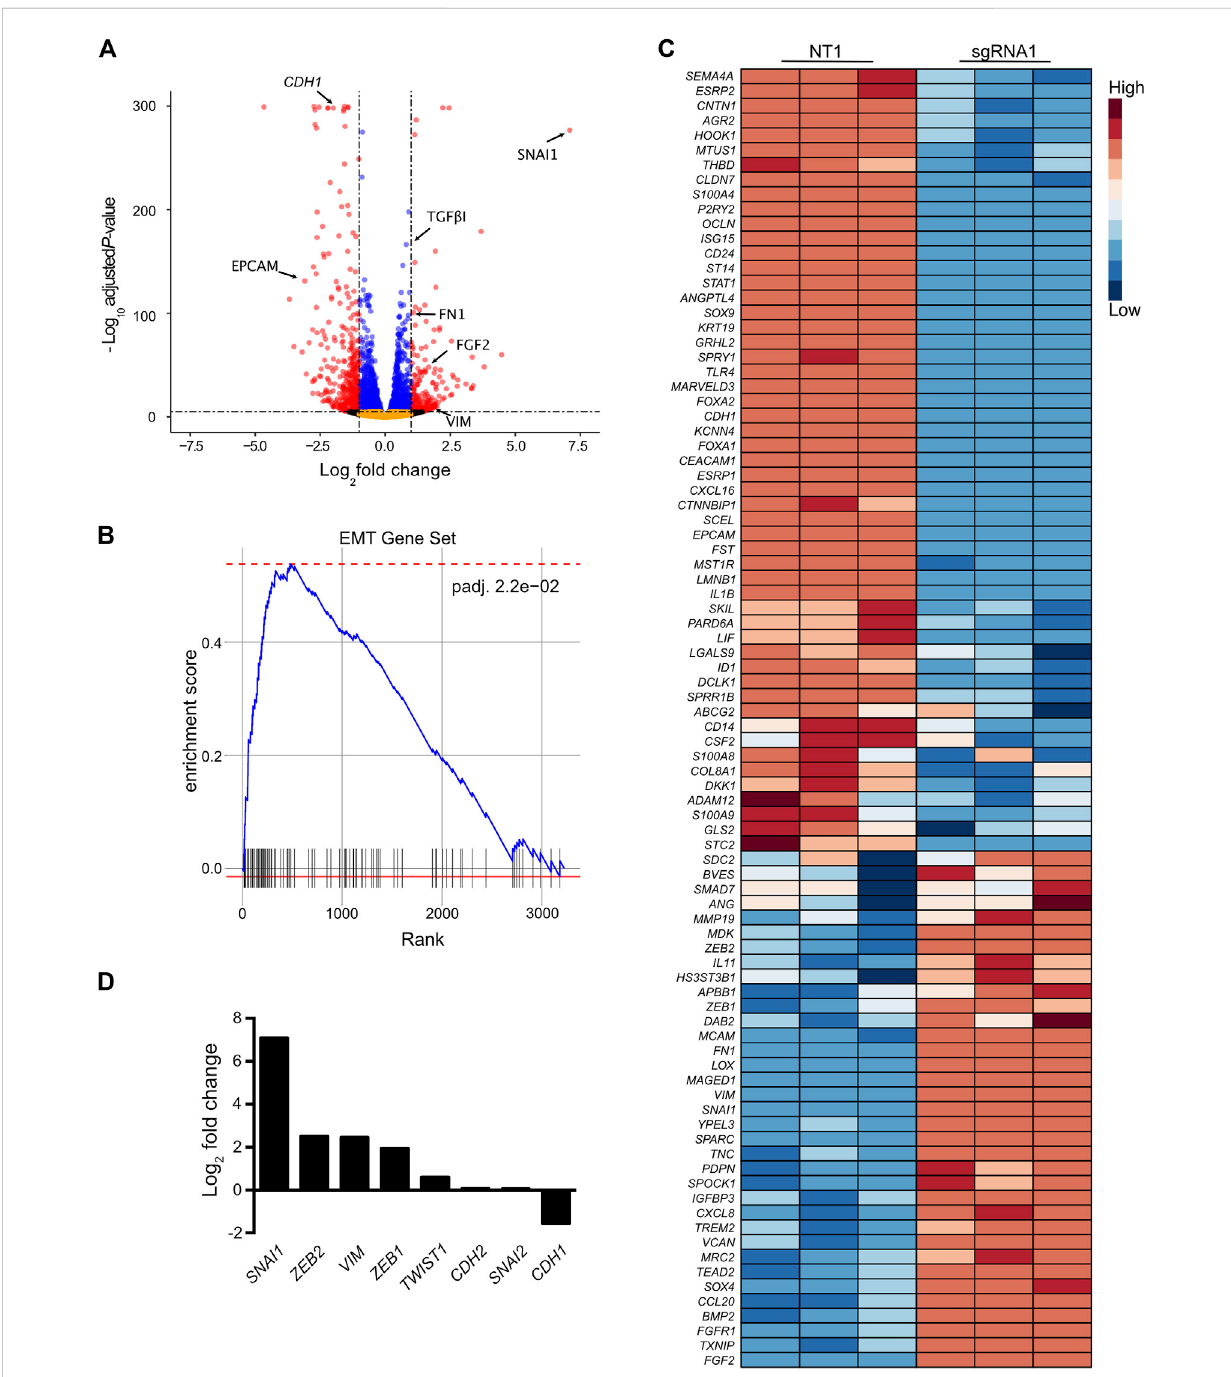
FIGURE 2 Activation of the SCREEM1 locus elicits a robust transcriptional reprogramming. (A) Volcano plot of expressed genes (TPM ≥ 1) between NT — sgRNA and SCREEM1 locus targeting — sgRNA1 in CRISPR-activated HBEC3-KT cells. NT, non-targeting, n = 3. Red dots, adjusted p -value < 10 – 6 and log2 fold change > 1; blue dots, adjusted p -value < 10 – 6 and log2 fold change < 1; black dots, adjusted p -value > 10 – 6 and log2 fold change > 1; orange dots, > 10 – 6 andlog2foldchange < 1. (B) RankedorderedgenesetenrichmentanalysisofdifferentiallyexpressedgenesbetweenNT-sgRNAand SCREEM1 locus targeting-sgRNA. NT, non-targeting, n = 3. The EMT pathway is shown. (C) Heatmap of EMT-associated genes differentially expressed between NT- sgRNA and SCREEM1 locus targeting-sgRNA1. NT, non-targeting, n = 3. (D) Fold change of key EMT-associated genes differentially expressed between NT-sgRNA and SCREEM1 locus targeting-sgRNA1. NT, non-targeting, n = 3. NT, non-targeting, n =